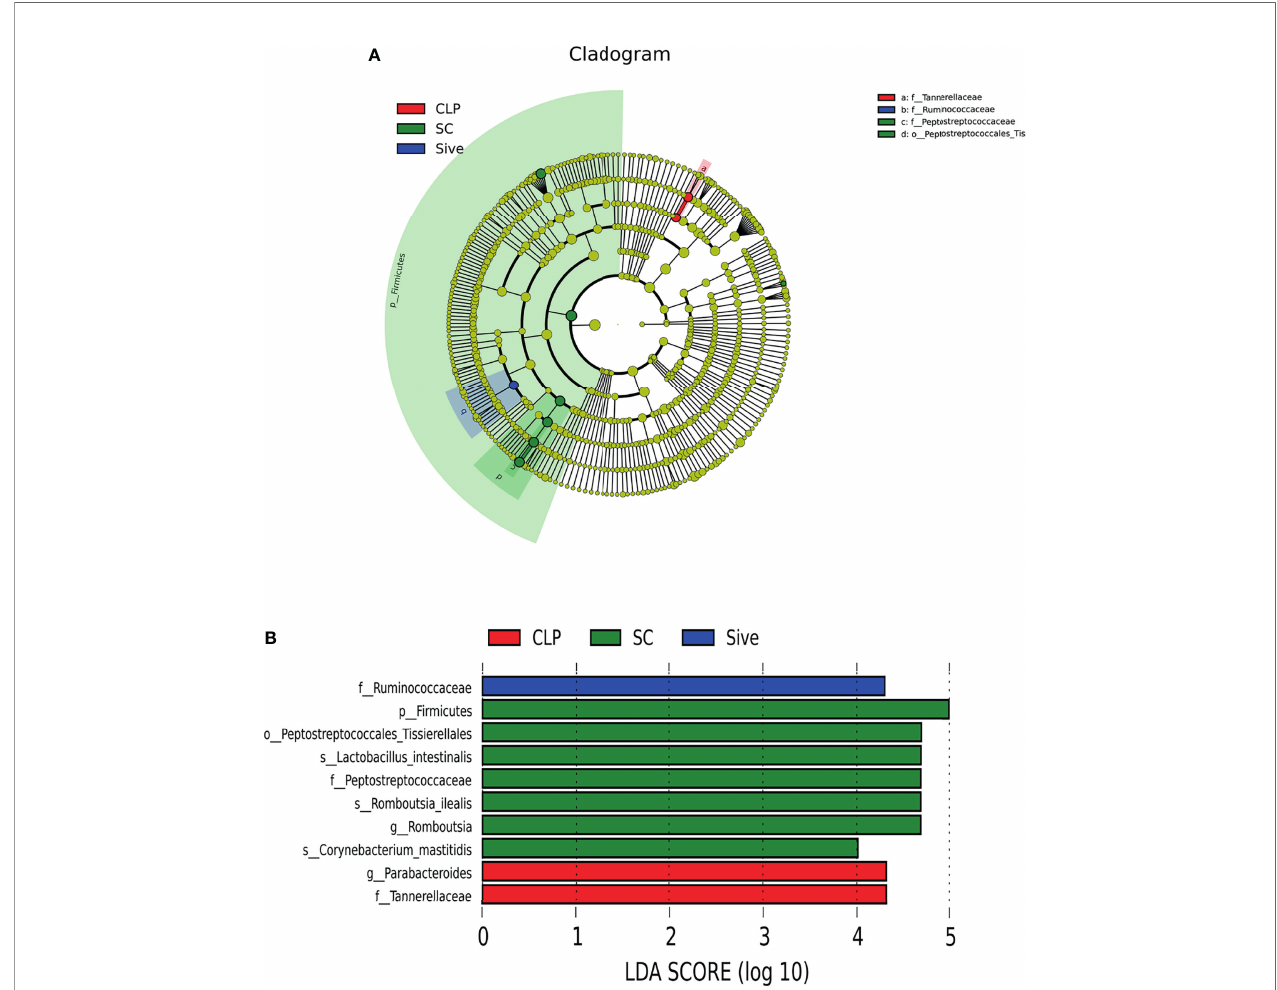
FIGURE 2 | Linear discriminant analysis (LDA) integrated with effect size (LEfSe). (A) Taxonomic cladogram showing the phylogenetic distribution of the microbiota among experimental groups. (B) Bacteria with signi fi cant between-group differences (LDA